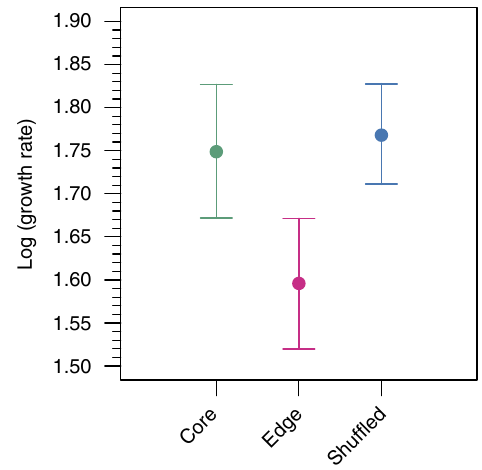
Figure 3 | Evolved intrinsic growth rates among spatial locations and shuffled populations. The mean natural log of growth rate (defined as the ratio of population density at time t þ 1 to population density at time t ) for G1 descendants of beetles taken from the core and edge of structured landscapes and G1 descendants from shuffled landscapes. As there was no significant difference in density dependence of growth rates among core, edge and shuffled beetles, filled circles represent model estimates averaged over density levels from a linear mixed effects model and provide a relative measure of intrinsic growth rate. The numbers of samples at each of the four density levels respectively were: core, n ¼ 20, 24, 22 and 22; edge, n ¼ 23, 27, 23 and 23; and shuffled, n ¼ 38, 48, 39 and 39. Sample sizes differ among locations and densities because of variation in the number of G1 offspring available. Error bars are bootstrapped 95% confidence intervals.